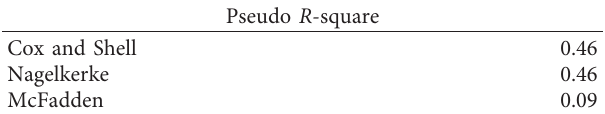
Table 7: Pseudo R -square.